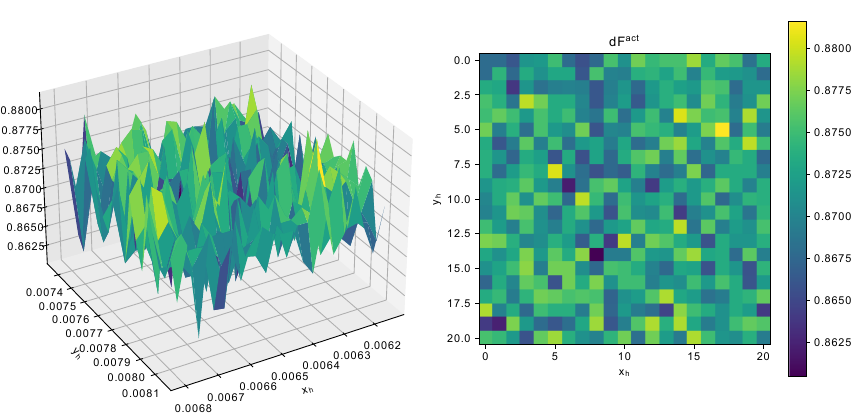
Figure 12. Dependence of dF act around scaled solution for 5-mode resonator.